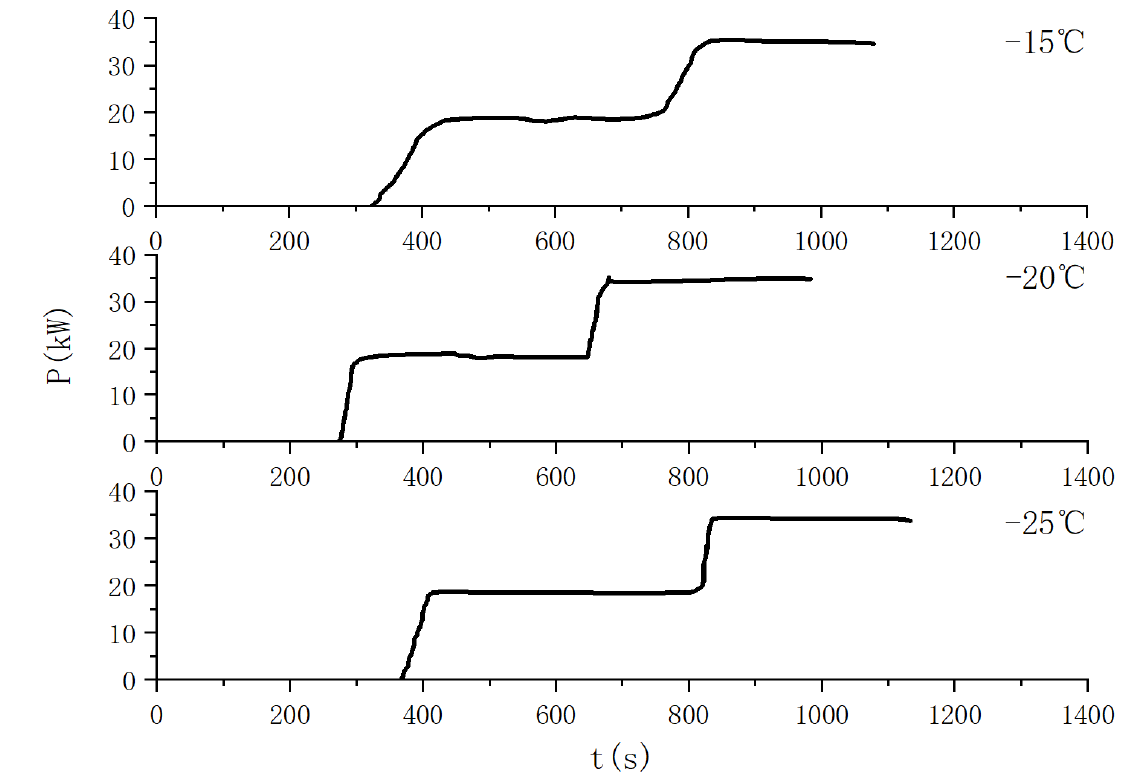
Figure 5. Graph of the power change in Stack B with time.